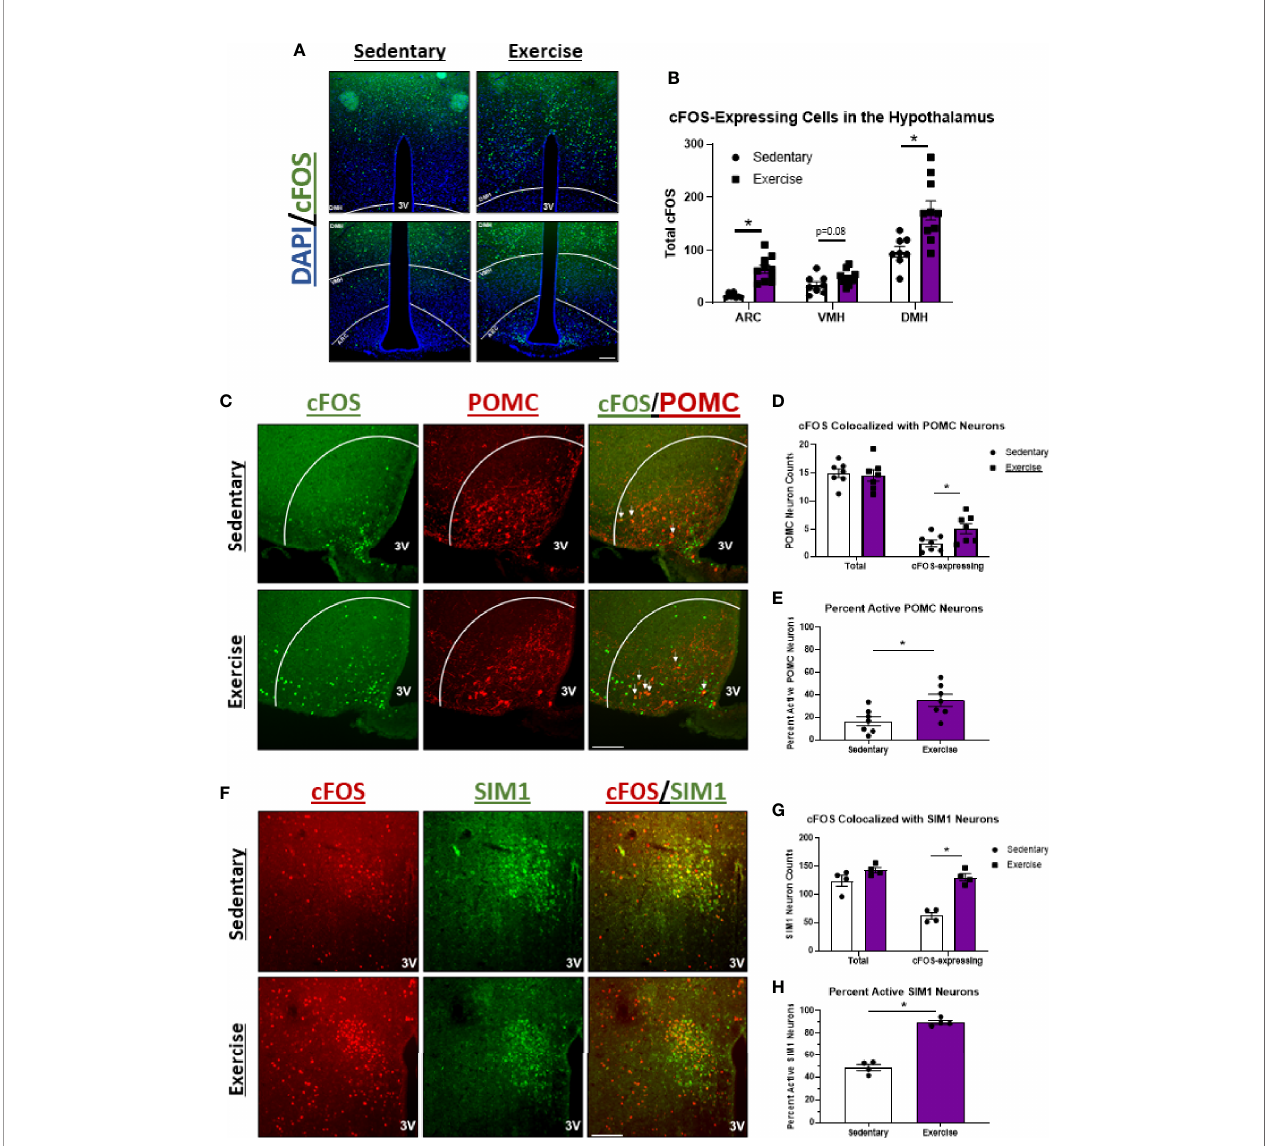
FIGURE 2 | POMC ARC and SIM1 PVN neuron activity is elevated 1 hour after acute high intensity treadmill exercise in fasted male mice. (A) Representative images of cFOS (green) in the hypothalamus of fasted male mice 1 hour after sedentary trials or high intensity treadmill exercise (DAPI in blue). (B) Total cFOS-expressing cells in each region of the hypothalamus (n=10/group) DMH=dorsomedial hypothalamus; VMH=ventromedial hypothalamus; ARC=arcuate nucleus. (C) Representative images of cFOS (green) colocalized with POMC ARC neurons (red) in fasted male mice 1 hour after sedentary trials or high intensity treadmill exercise. (D) Total and cFOS-expressing POMC ARC neurons and (E) Percent active POMC ARC neurons (n = 7/group). (F) Representative images of cFOS (red) colocalized with SIM1 PVN neurons (green) in fasted male mice 1 hour after sedentary trials or high intensity treadmill exercise. (G) Total and cFOS-expressing SIM1 PVN neurons and (H) Percent active SIM1 PVN neurons (n = 4/group). 3V = Third ventricle; Scale bar = 50um. Data represented as mean ± SEM. *indicates p < 0.05 vs. sedentary